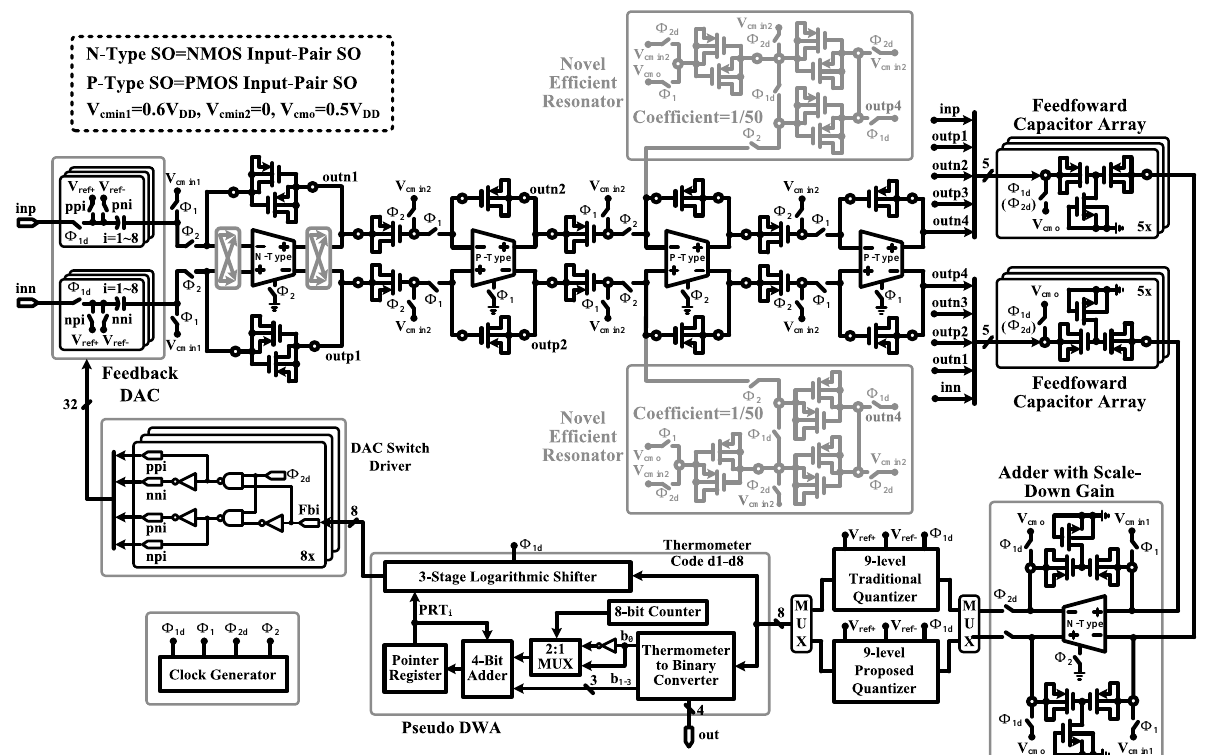
Figure 14. Circuit schematic of the proposed modulator. The amplifiers in the first-stage integrator and feed-forward signal summation block are designed with NMOS input-pair switched op-amp, while other amplifiers are designed with PMOS input-pair switched op-amp. A DAC switch driver is adopted to reduce the number of the feedback signals from pseudo